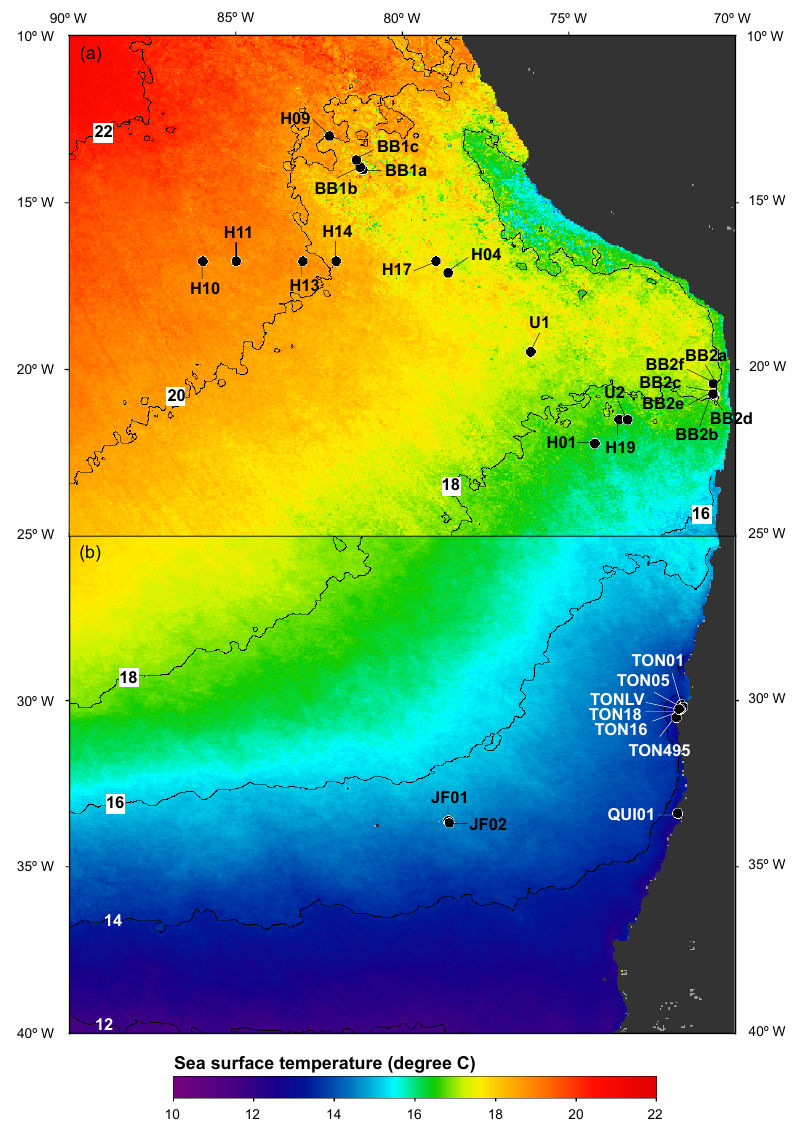
Figure 1. Map of stations sampled during the NBP 1305 cruise (June–July 2013) (a) and in smaller field expeditions of